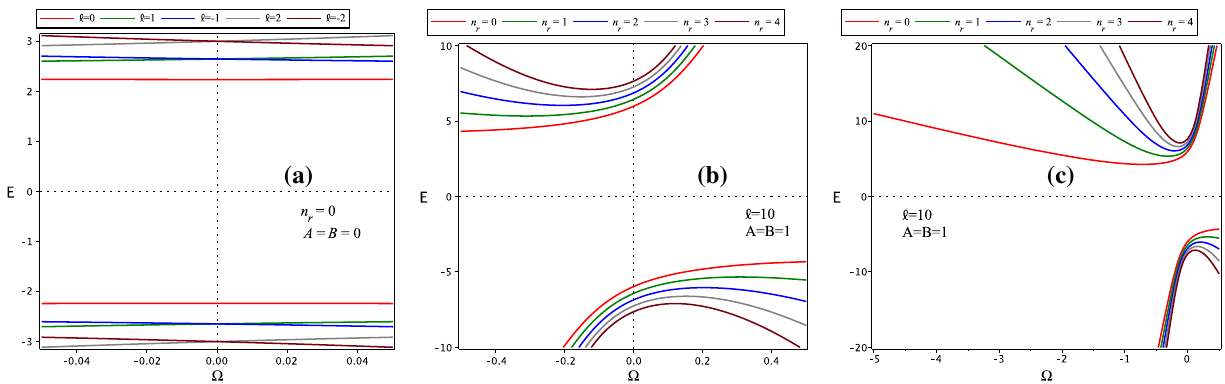
Fig. 4 a Corresponds to Fig. 1a but with the vorticity parameter (cid:2) ∈ [− 0 . 05 , 0 . 05 ] , b corresponds to Fig. 3e but with the vorticity parameter (cid:2) ∈ [− 0 . 5 , 0 . 5 ] , and c corresponds to b above but with (cid:2) ∈ [− 5 , 0 . 5